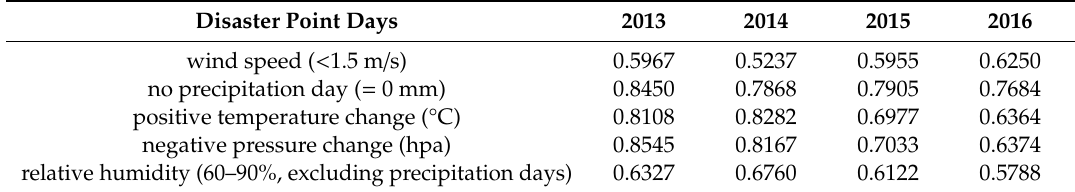
Table A1. Grey correlation between disaster point days and PM 2.5 pollution days.